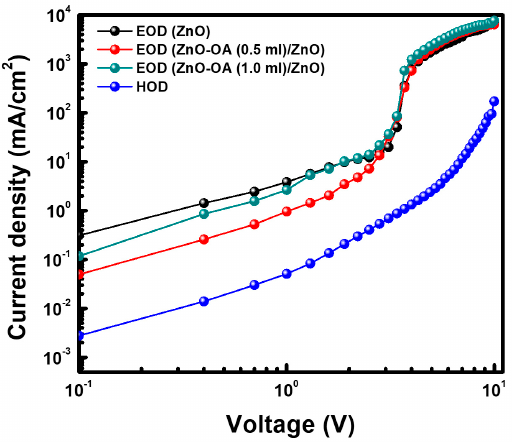
Figure 16. Current density (J) − voltage (V) curves of EODs and HOD.